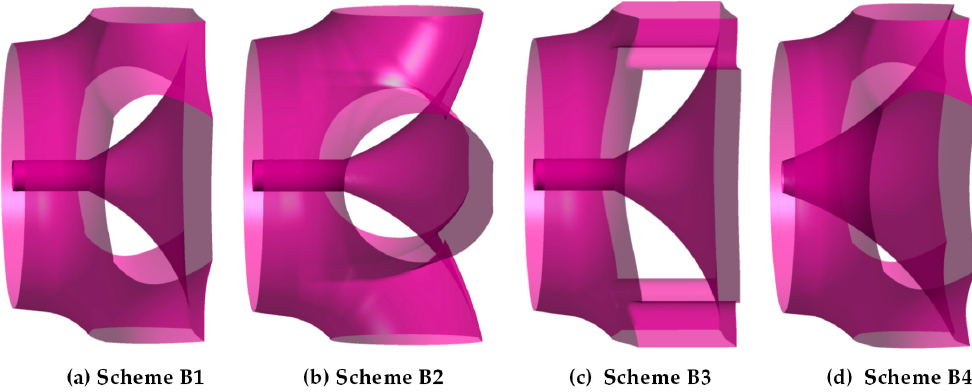
Figure 7. Schematic diagrams of different multiple-outlet elbow-shaped draft tubes. ( a ) Scheme B1; ( b ) Scheme B2; ( c ) Scheme B3 and ( d ) Scheme B4.